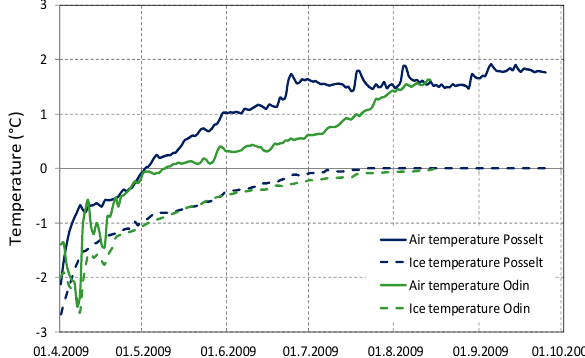
Fig. 9. Daily means of air temperature and ice temperature at two sites (Odinsaal and Posselthalle) in the cave Eisriesenwelt for the period 1 April 2009 to 30 September 2009.